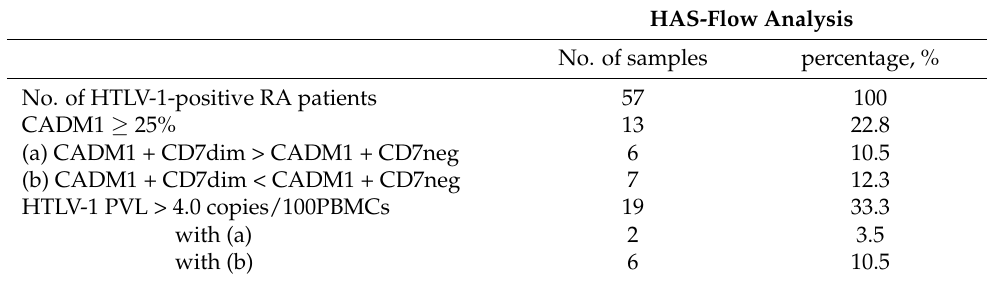
Table 2. HAS-Flow results and proportion of HTLV-1-positive RA participants with high proviral load (PVL) values.